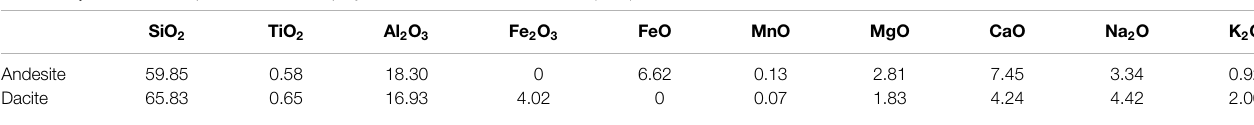
TABLE 2 | Chemical composition of the employed andesitic and dacitic melts (wt%).